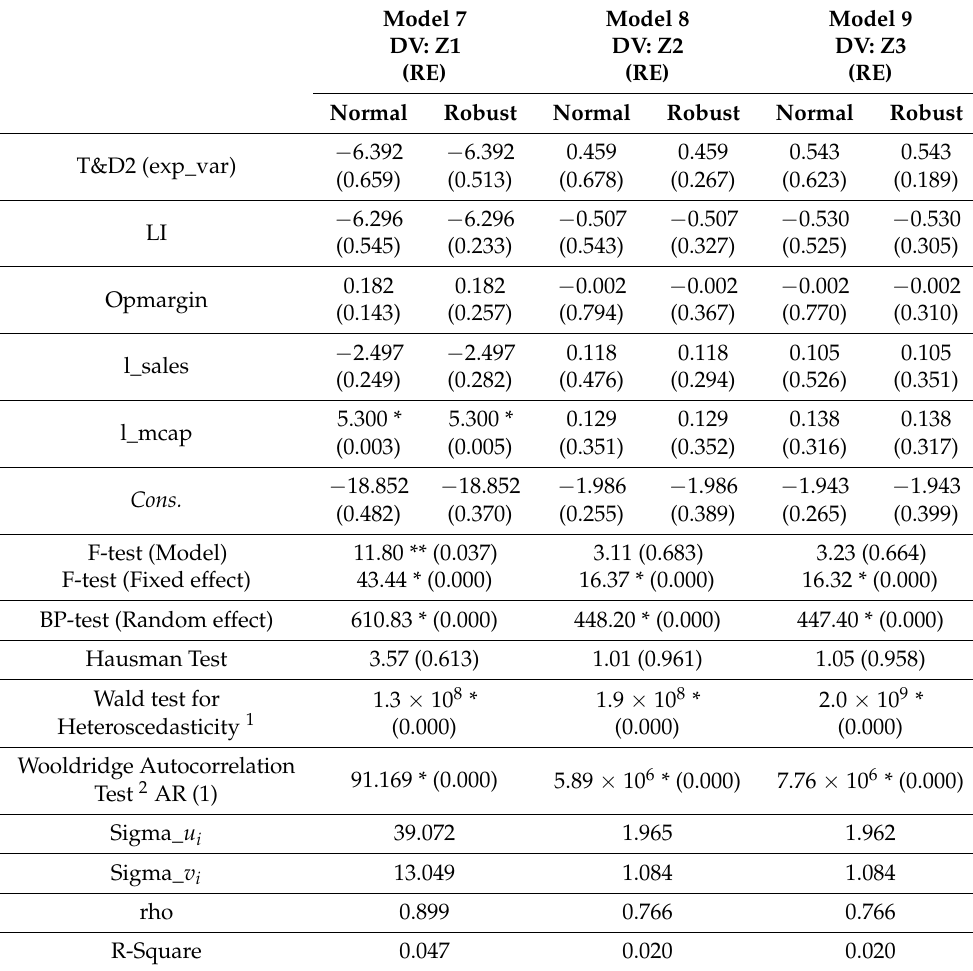
Table 6. Static Models for Nonlinear